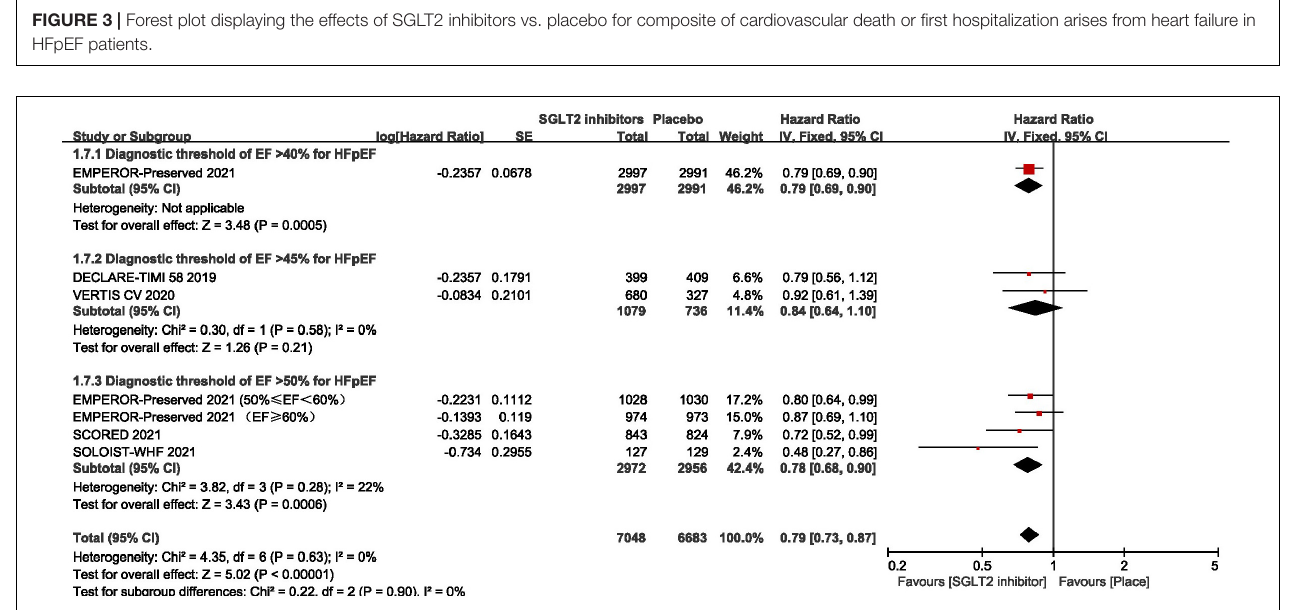
difference was found between SGLT2 inhibitors and placebo in terms of the all-cause mortality (RR: 0.99, 95% CI: Figure 9 .